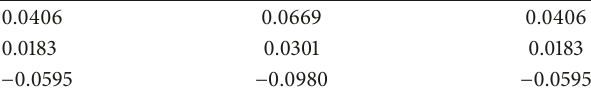
Table 1: 𝐺 𝑥 fractional Gaussian template.